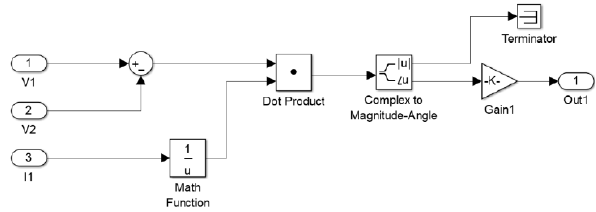
According to Figure 9, the simulation model of 110kV